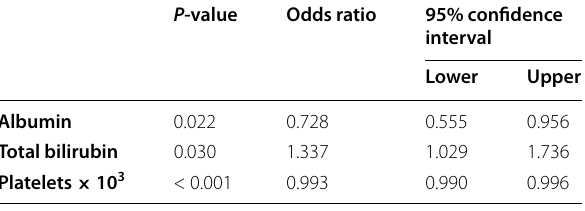
Table 3 Multivariate regression analysis for prediction of hepatic